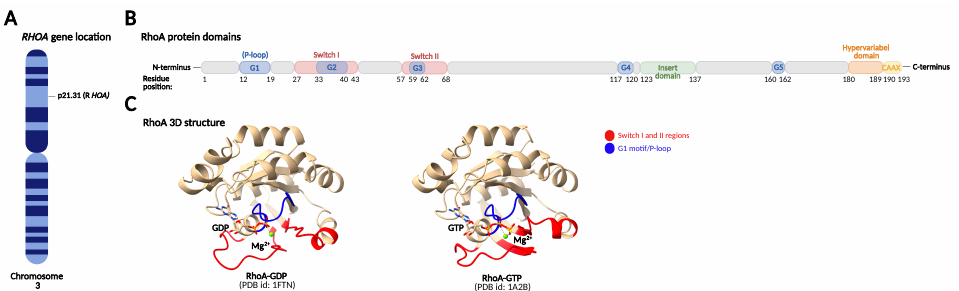
Figure 1. RhoA protein domains and 3D structure. ( A ) The RHOA gene is located on the short arm of chromosome 3 (3p21.3). ( B ) RhoA is a monomeric protein comprised of 193 amino acids and a molecular mass of 21.7 kDa. The different domains and their amino acid positions are marked. The G- domain responsible for nucleotide binding contains five motifs, G1–G5, where the G2 and G3 motifs are located in the switch I and II regions that change conformation in response to GTP/GDP binding. The insert domain and the hypervariable C-terminus are involved in regulatory or effector protein binding, while the CAAX motif in the C-terminal end undergoes post-translational lipid modification crucial for membrane targeting. ( C ) 3D structure and conformation of the RhoA–GDP complex and the RhoA–GTP complex. Marked in blue is the P-loop (G1 motif) that binds the β , γ -phosphate of the guanine nucleotide and a Mg 2+ ion. Marked in red are the switch I and II regions responsible for the conformational change of the protein in response to GTP/GDP